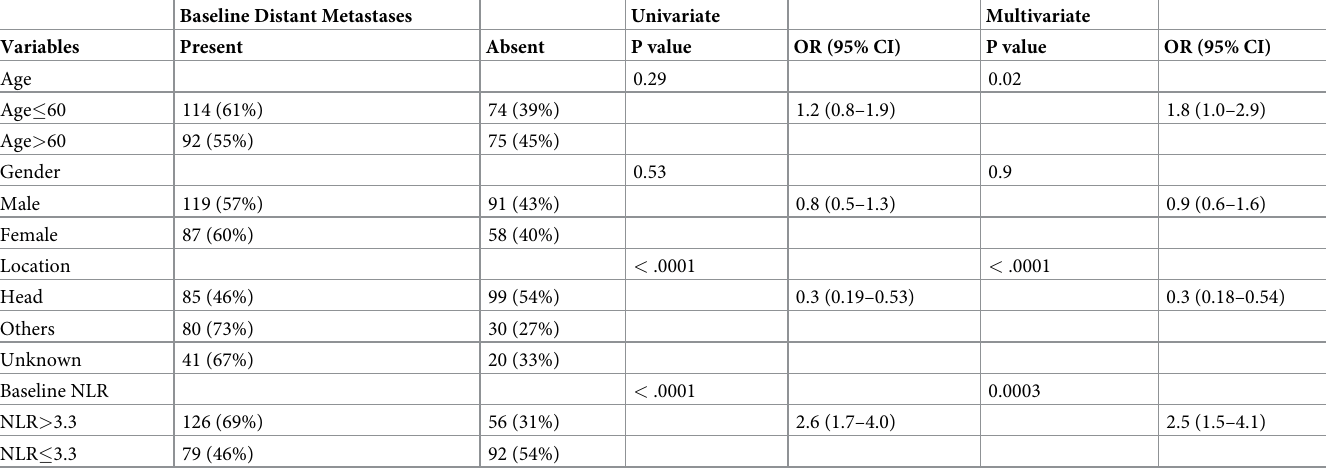
Table 3. Univariate and multivariate analyses for the association of different variables with the presence of baseline distant metastases. Baseline Distant Metastases Univariate Multivariate Variables